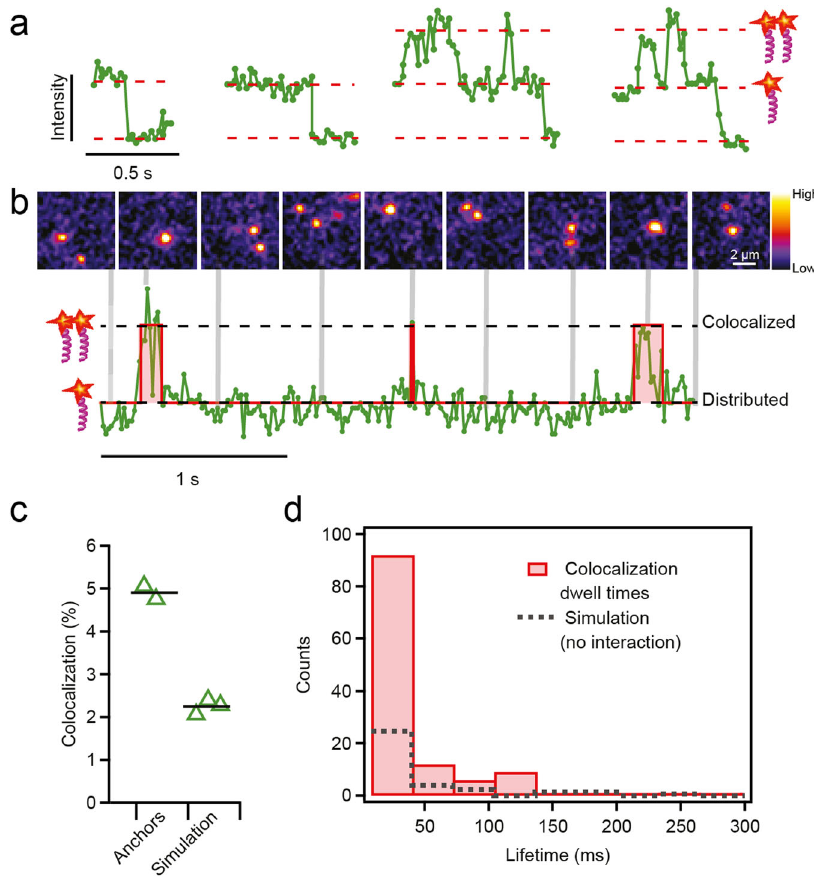
Fig. 3 Colocalization of POR anchors at the membrane. a Representative single molecule intensity traces. The fi rst two traces exhibit single-step photobleaching whereas the last two traces show regions with double brightness, indicative of dynamic colocalization. b An extended single molecule intensity trace and corresponding micrograph snapshots with timings indicated by the vertical grey lines. Regions of double brightness in the intensity trace corresponds to colocalization of two anchors in the micrographs. The intensity trace is segmented and fi tted with a two state model (red trace) employing a change point detection algorithm (see methods). To ease visualization shown micrographs were smoothed using a 3×3 Gaussian kernel. c Colocalization of reconstituted anchors compared to coincident colocalization due to random overlap. Each triangle re fl ects colocalization percentage calculated from trajectories from a single movie/GUV, or a single simulation run, and employing the analysis procedure illustrated in ( b ). d Histograms of colocalization event durations. Single molecule trajectories from the two GUVs included in panel c were joined and analyzed to extract colocalization event dwell times (121 events total). The average histogram of 3 corresponding traces resulting from the simulated data is shown for comparison, each with the same length as the original data being compared here (average number of events per simulated trace was 34 with individual traces showing 22, 34, and 47 events). Source data are available in Supplementary Data